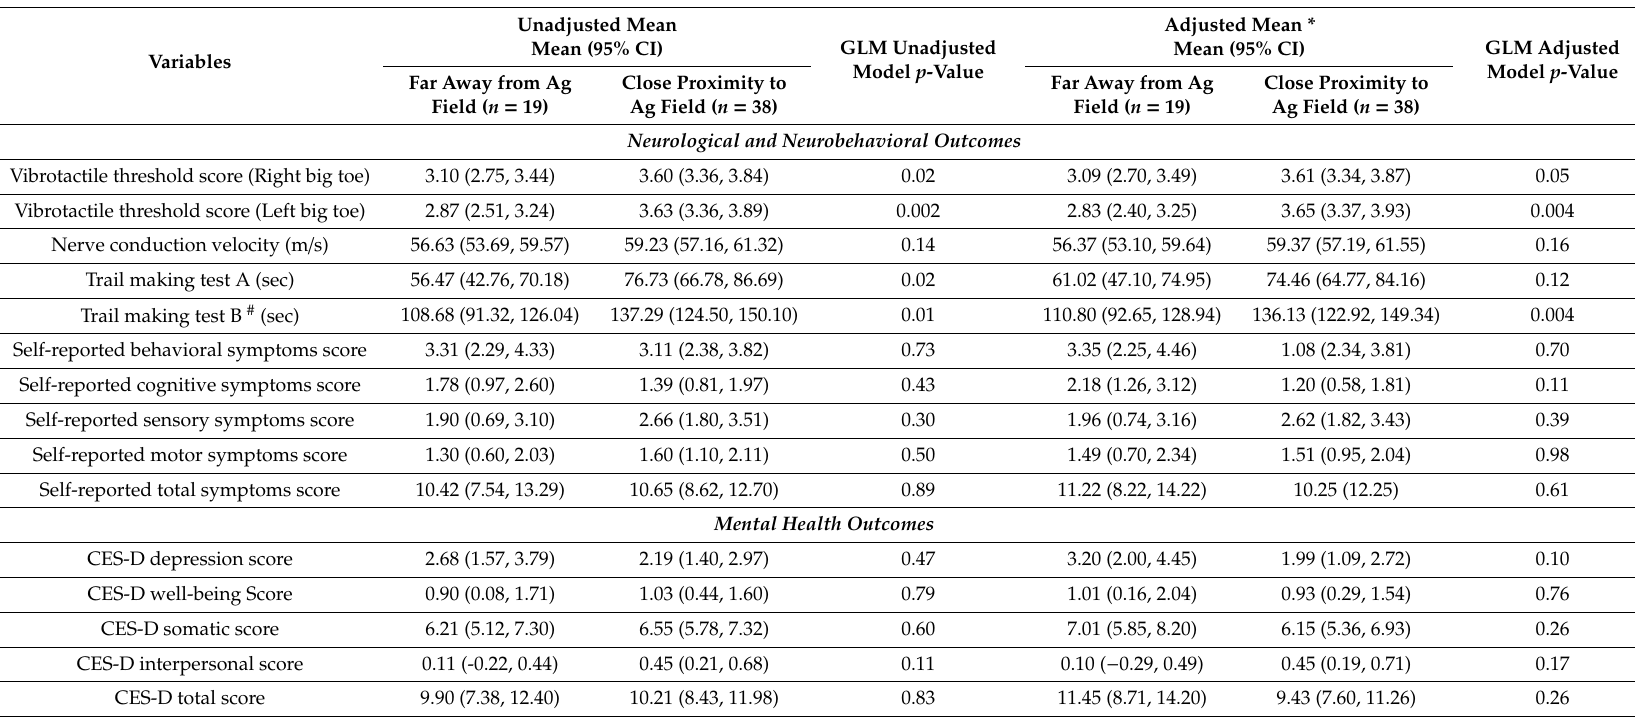
Table 3. Association of proximity of agricultural (Ag) field with neurological, neurobehavioral and mental health outcomes.